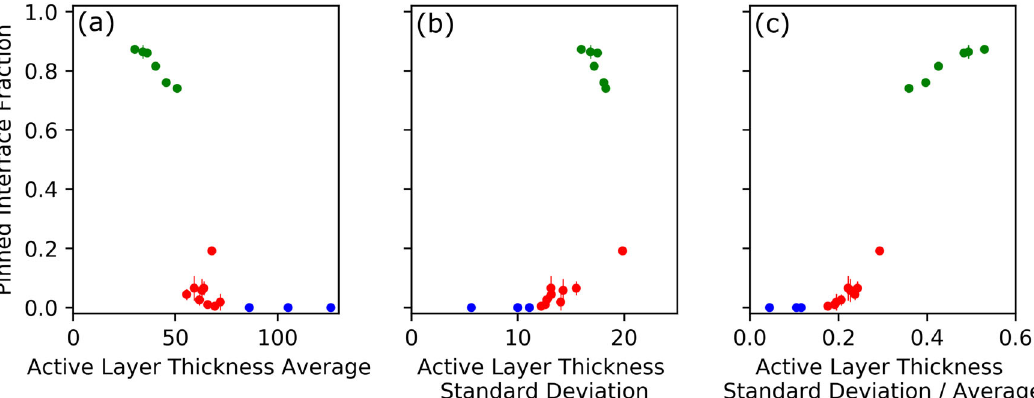
Fig. 7 Phase diagram for the pinning transition. In each panel, our chosen order parameter, the average steady-state pinned interface fraction, is plotted against three potential control parameters for the data from our simulations. These are the average active layer thickness ( a ), the steady state of the standard deviation of the active layer thickness ( b ), and the steady state coef fi cient of variation (i.e. standard deviation/mean) of the active layer thickness ( c ). Simulation data points are coloured according to whether the simulation is in the unpinned (blue), transiently pinned (red) or pinned (blue) phase. The simulations included in our plot are as in Fig. 4, but the transitional simulations (see Fig. 5) are not included. The simulation with μ max = 0.4 1/h, S bulk = 0.005 is also not included, as it had not fully reached the steady state (see Supplementary Fig. 8). To gain resolution in the transition region, we also included additional simulations in the transiently pinned phase, with parameter values of μ max = 0.3 1/h, S bulk = 0.007 g/L; μ max = 0.33 1/h, S bulk = 0.01 g/L, μ max = 0.45 1/h, S bulk = 0.01 g/L; μ max = 0.25 1/h, S bulk = 0.005 g/L; μ max = 0.37 1/h, S bulk = 0.01 g/L. Error bars are calculated using the standard error of the mean for correlated data (see